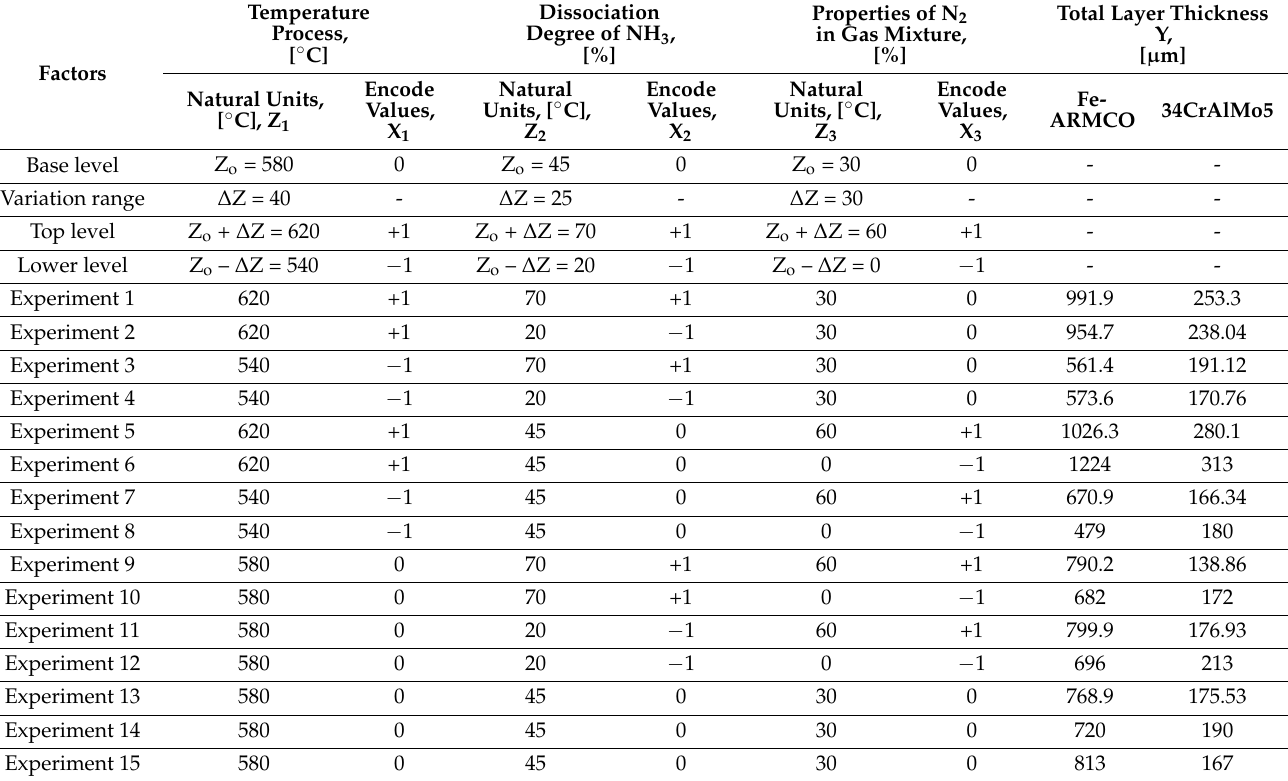
Table 1. The 2nd order non-compositional program ( K = 3); correspondence between natural and codified values of the independent parameters; actual conditions for carrying out the experiences and the